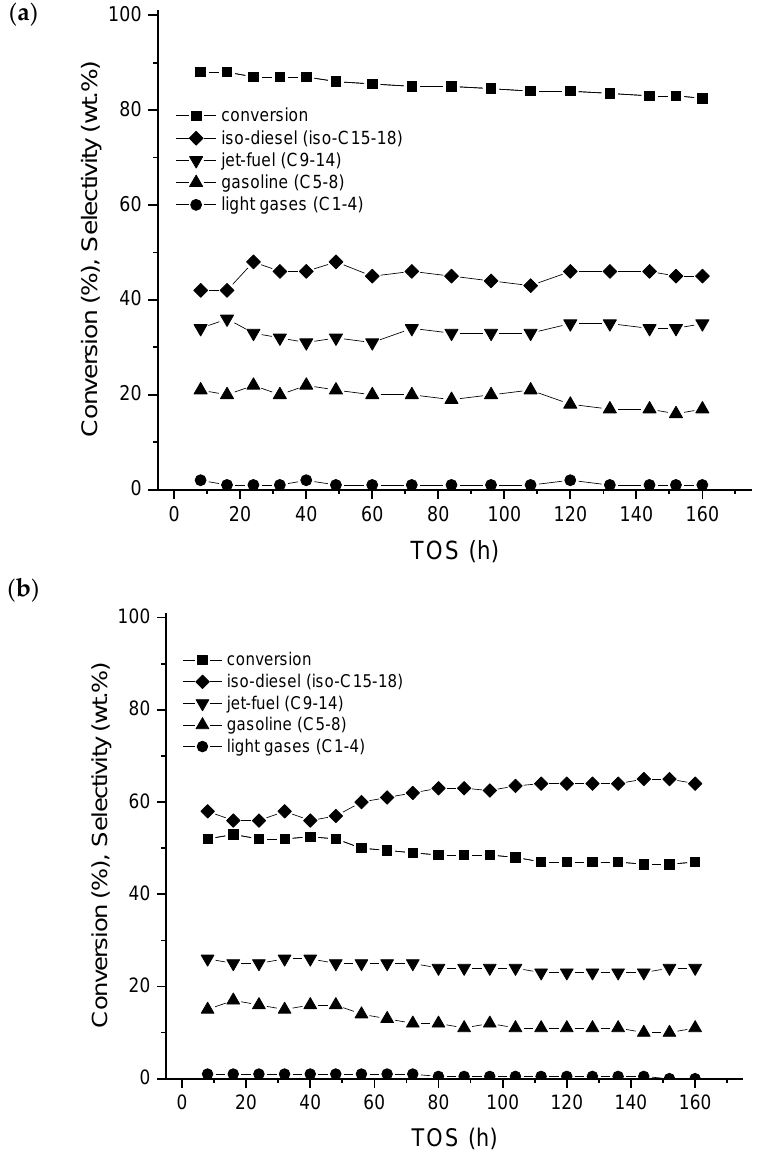
Figure 15. The effect of LHSV: of ( a ) 1.0 hr − 1 and ( b ) 4.0 hr − 1 , at 310 ◦ C under 31 bar using H 2 /BDH molar ratio of 30 in the hydroisomerization of C15–C18 alkanes over Pt-HY-100 (a Si/Al ratio of 100), conversion and selectivity as a function of time-on-stream adapted from [17]. Reproduced with permission from Hengsawad, et al., Ind. Eng. Chem. Res. ; published by American Chemical Society, 2018 .